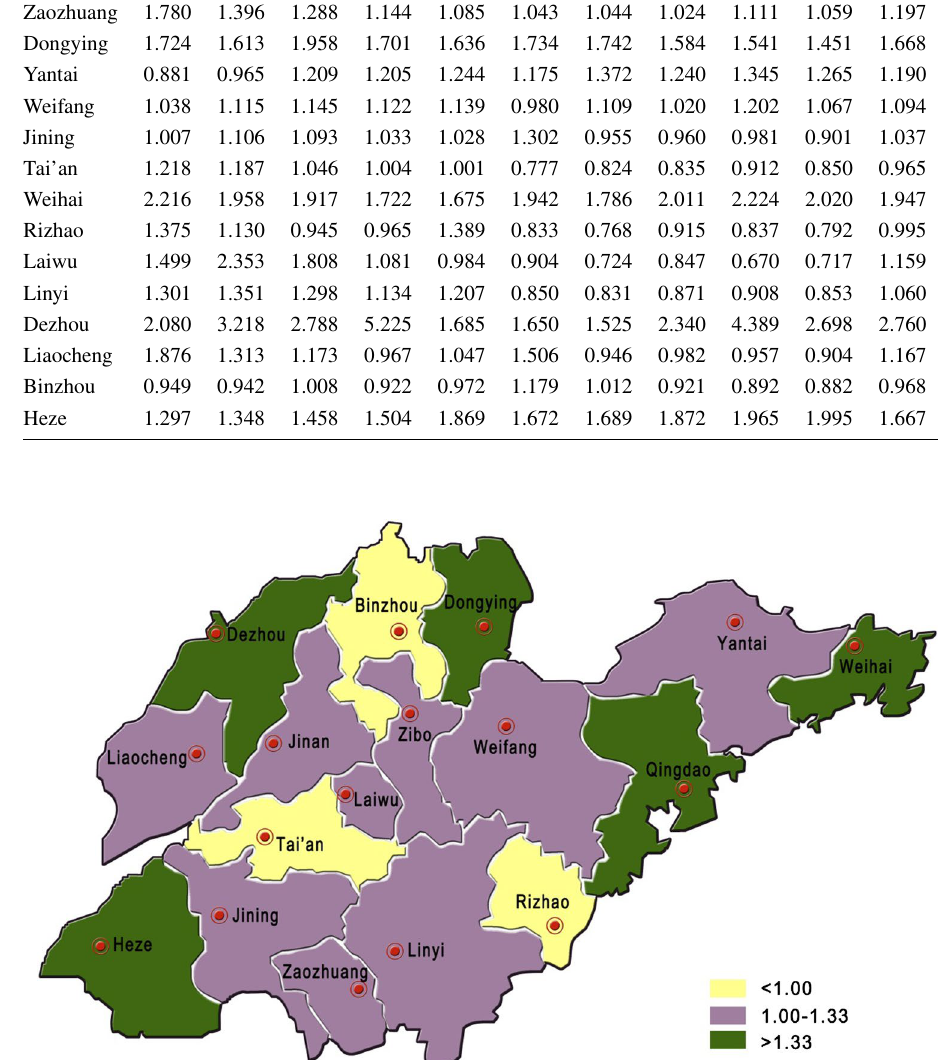
scores of 17 cities in Shandong Province for the period